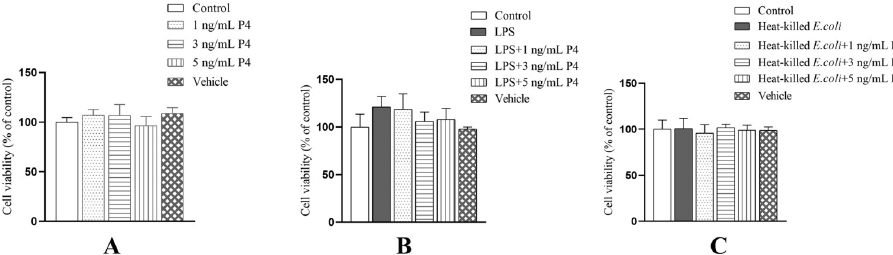
Fig 1. The changes in cell viability of primary bovine endometrial stromal cells using Cell Counting Kit-8 method. The cells were treated with 1, 3, or 5 ng/mL progesterone (A), 1 μ g/mL lipopolysaccharide and progesterone (B), or 1 × 10 8 CFU/mL heat-killed E . coli and progesterone (C) for 24 h. The vehicle is 0.5% alcohol. P4, progesterone. LPS, lipopolysaccharide. All data were presented as means ± SEM (n � 3).